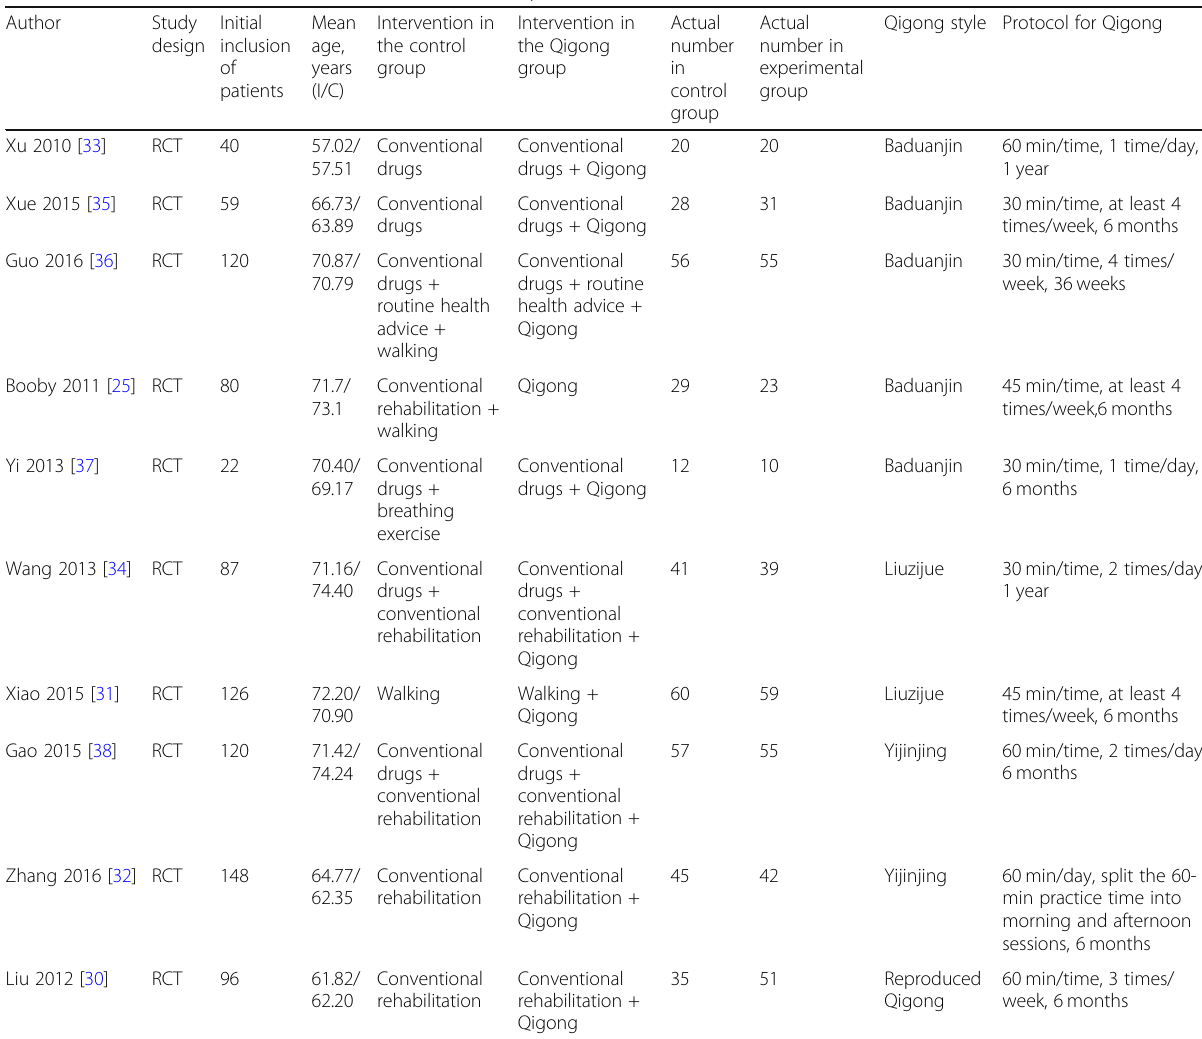
Table 1 The detailed characteristics of each selected study Author Study Initial design